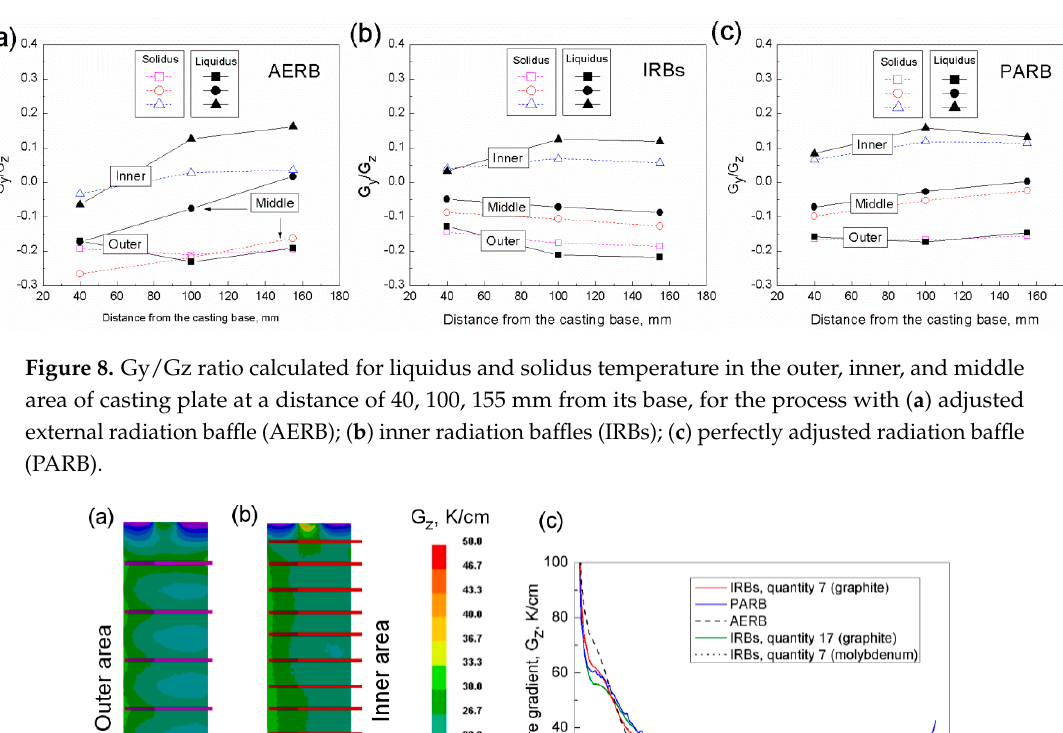
Figure 7. Predicted shape of the mushy zone in casting for various time points after the beginning of the filled mold withdrawal for the process with the application of ( a – c ) adjusted external radiation baffle (AERB); ( d – g ) inner radiation baffles (IRBs); ( h – j ) perfectly adjusted radiation baffle (PARB), where 1–7 are IRBs; Gz, Gy, and G is axial, transverse, and total temperature gradient, respectively; α is inclination angle.